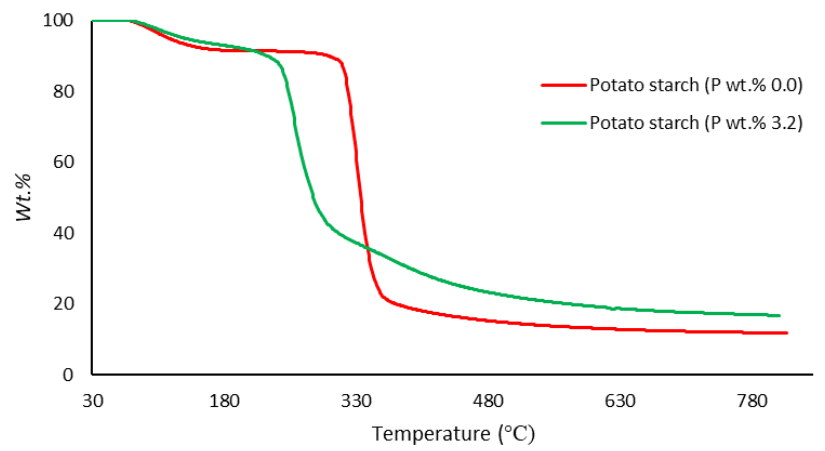
Figure 5. Thermograms of modified and unmodified versions of potato starch at 60 ◦ C /